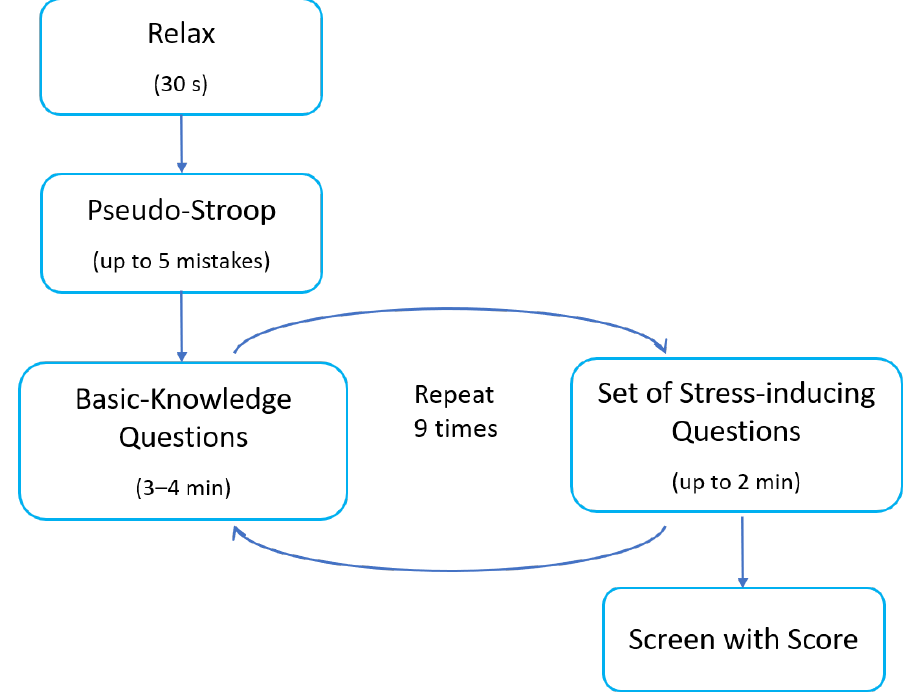
Figure 1. The order of events in Task